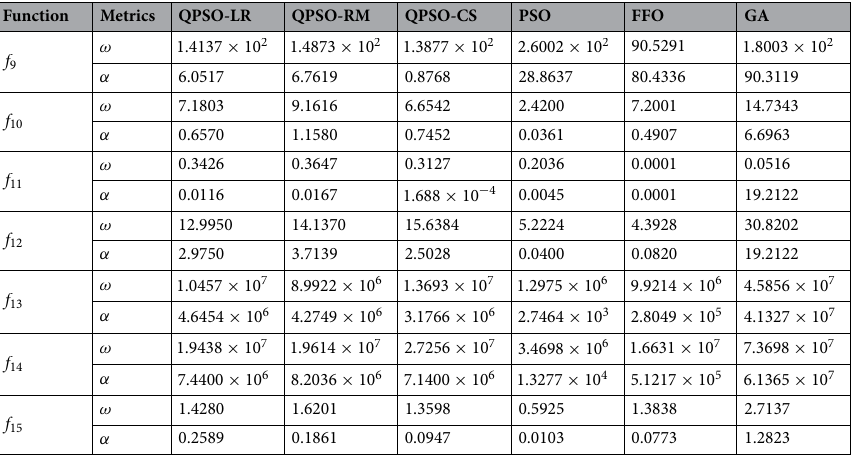
Table 5. Accuracy and precision metrics for multimodal benchmark functions with N = 30, Tmax = 1000 and Texp = 30.